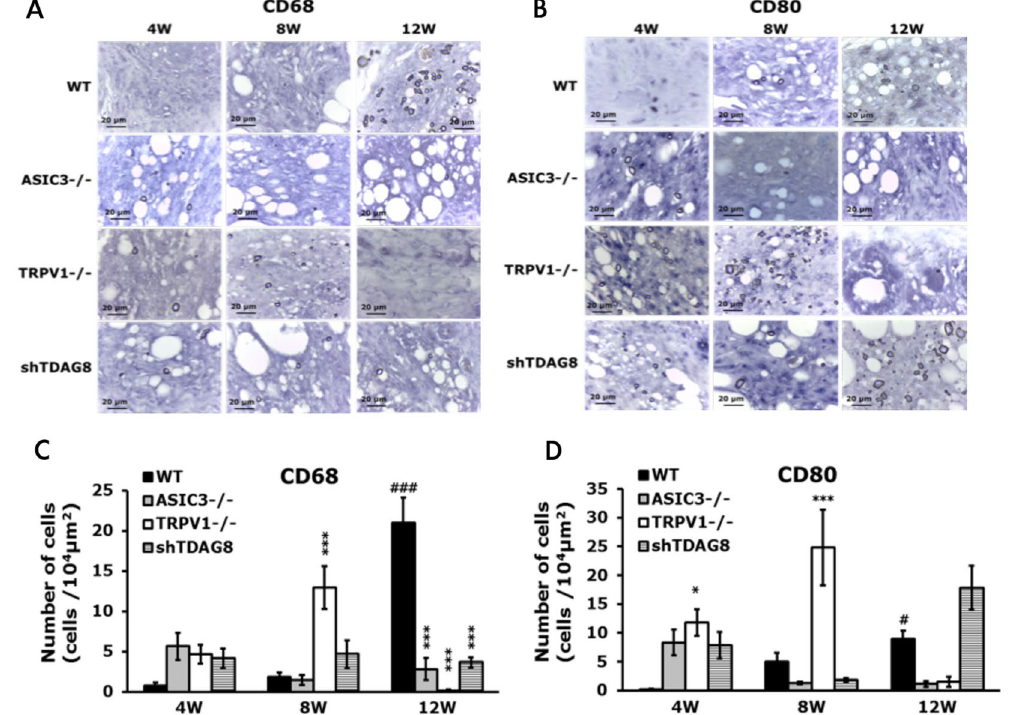
Figure 7. ASIC3- or TRPV1-deficiency or shTDAG8 knockdown reduces synovial CD68 + macrophages at 12 weeks Samples of ipsilateral joints from WT, ASIC3 − / − , TRPV1 − / − , shTDAG knockdown mice at 4, 8, 12 weeks were stained with CD68 ( A , C ) or CD80 ( B , D ) antibodies. Synovial sublining regions are shown in ( A , B ). Magnification, 100x. The number of cells in 100 × 100 μ m 2 was calculated and presented as histograms ( C , D ). # p < 0.05, ### p < 0.001, compared with 4w; * p < 0.05, *** p < 0.001, compared with WT by one-way